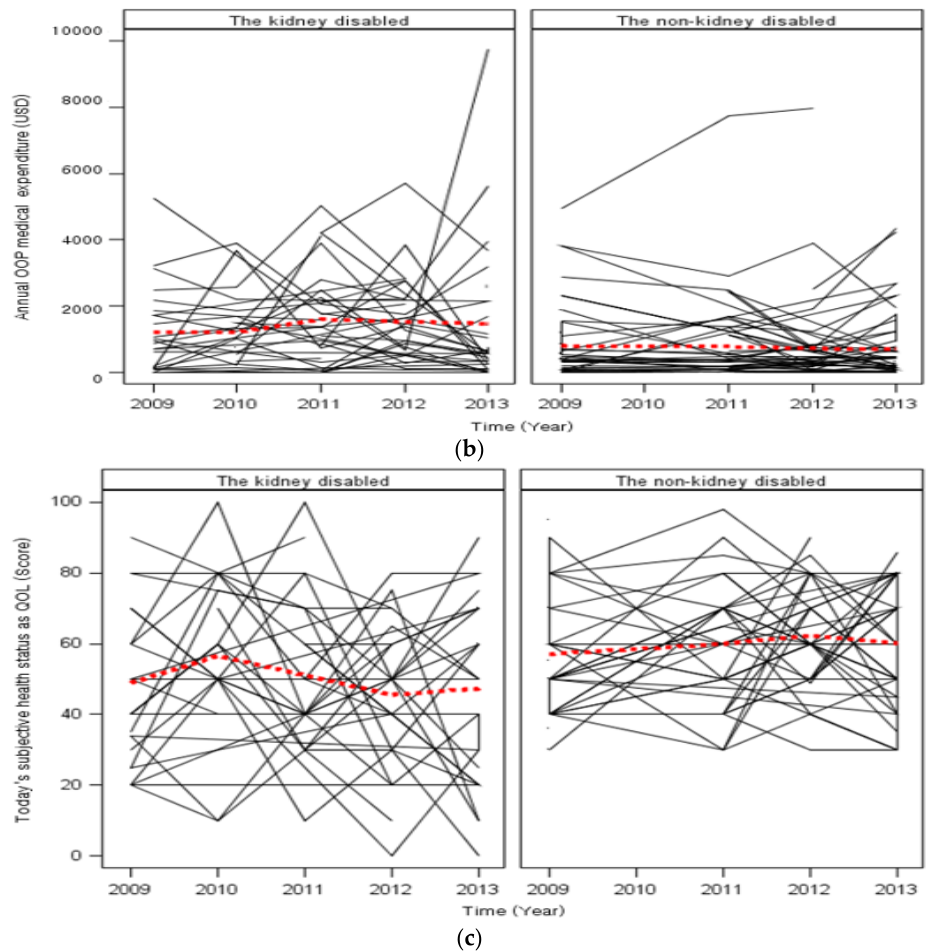
Figure 1. Five years of trends of chronic disease numbers, the OOP medical expenditure, and QOL in both groups by a mixed-effect model using unbalanced panel data. Thick red dotted lines refer to LOWESS curve, and other lines refer to the value of each subject. The covariate variables were age, gender, marital status, economic activity, and type of medical social security; ( a ) There was a difference between the kidney disabled and the non-kidney disabled in the five-year trend in the number of chronic disease ( p < 0.01); ( b ) There was a difference between the kidney disabled and the non-kidney disabled in the five-year trend in the annual OOP medical expenditure ( p < 0.01). ( c ) There was a difference in QOL (today’s subjective health status) in the five-year trend between the kidney disabled and the non-kidney disabled ( p < 0.001).